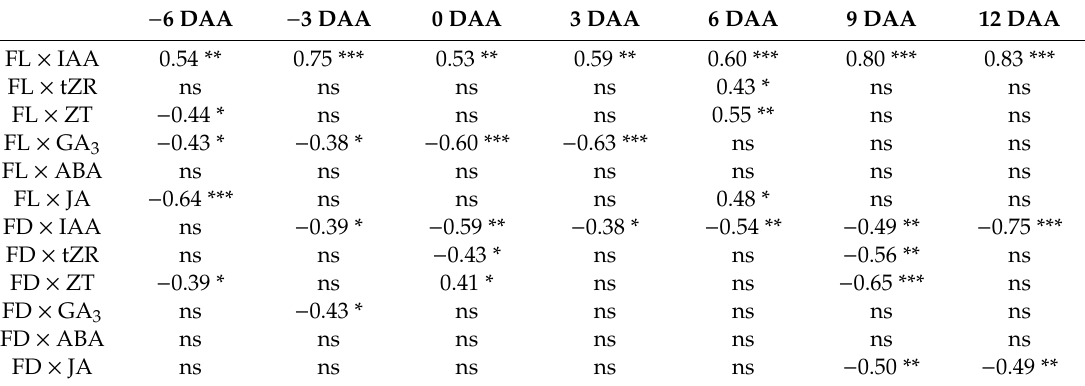
Table 4. Pearson correlation coe ffi cients among fruit length and diameter and endogenous hormones at di ff erent development